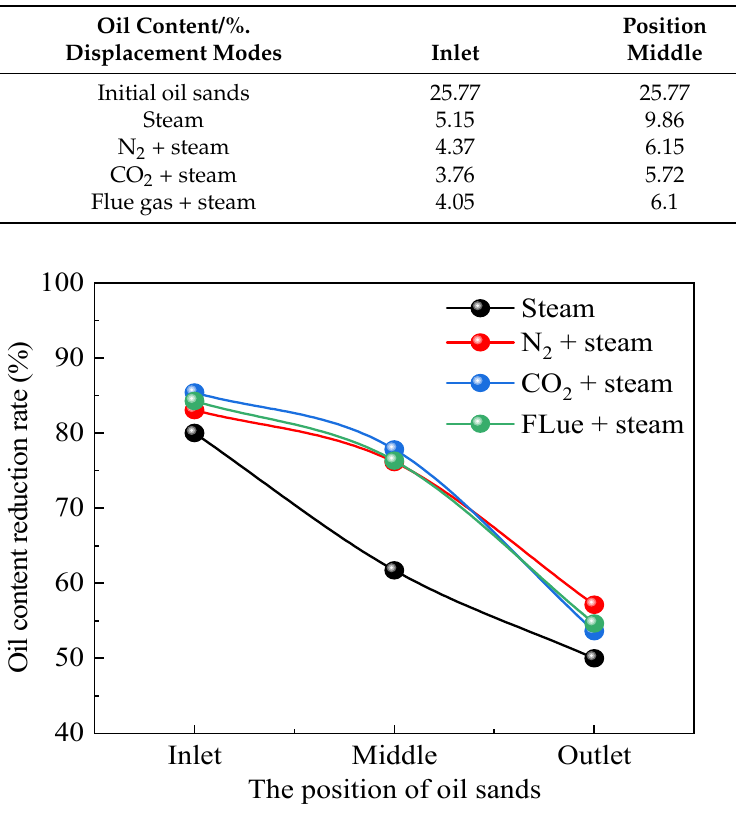
Figure 11. Comparison of oil content reduction rate of oil sands after displacement.